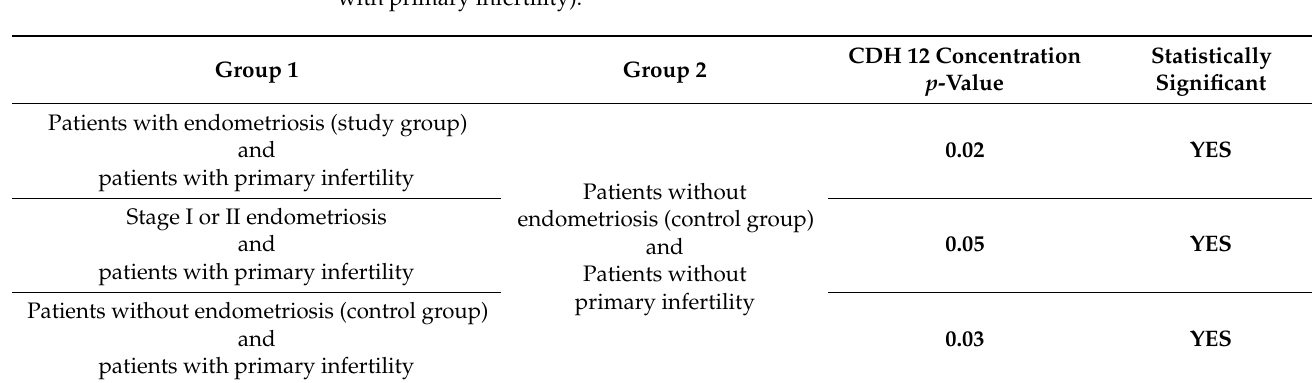
Table 4. Statistical significance of CDH12 concentrations between different groups (including patients with primary